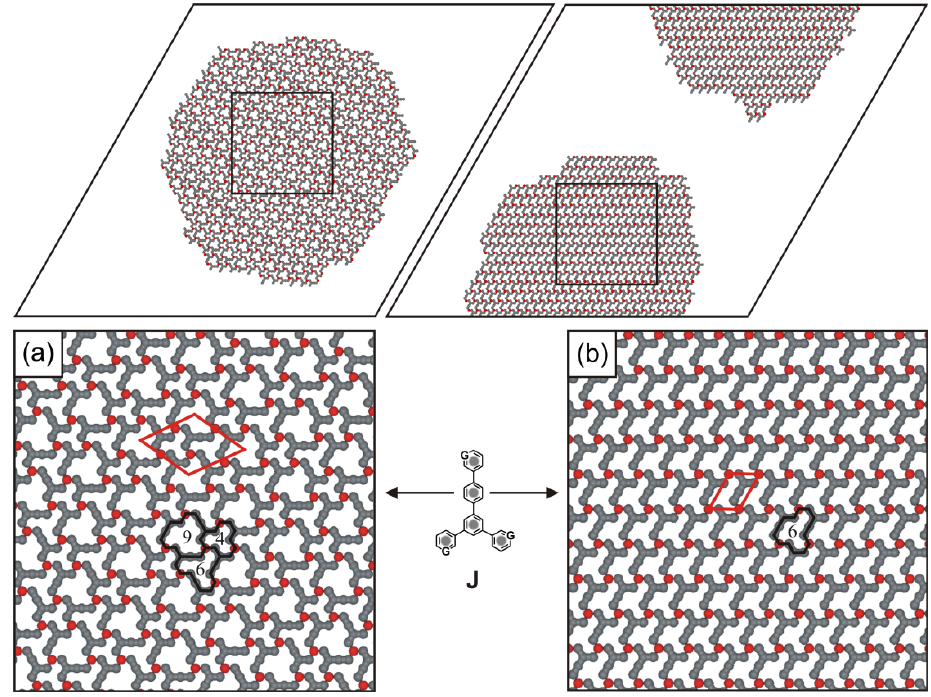
Figure 10. The polymorphic metal–organic superstructures obtained for molecule J : ( a ) a multiporous overlayer comprising 600 metal atoms and 600 ligands J in a 1:1 stoichiometric ratio; ( b ) a homogenous network composed of 600 metal atoms and 600 ligands J in a 1:1 stoichiometric ratio. In the magnified fragments of the 2D patterns, the rhombic unit cells are marked (solid red lines). The solid black lines delimit the edges of empty nanopores differing in size and shape. Inside the highlighted nanopores, the numbers of empty adsorption sites are given.